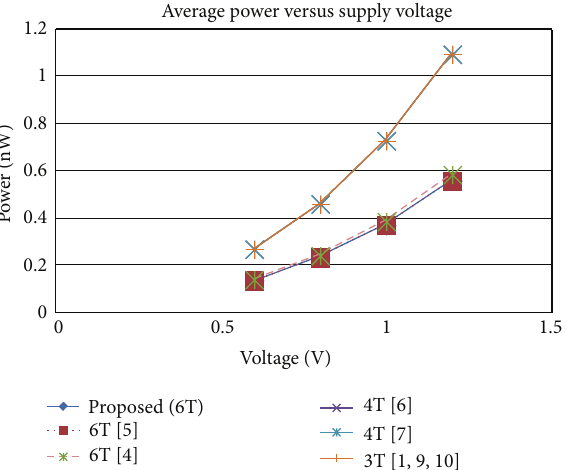
Figure 4: Line graph showing the comparison of the power dissipation versus supply voltage scaling for different CMOS XOR gates with the proposed novel CMOS pass-transistor-based full- swing XOR gate.